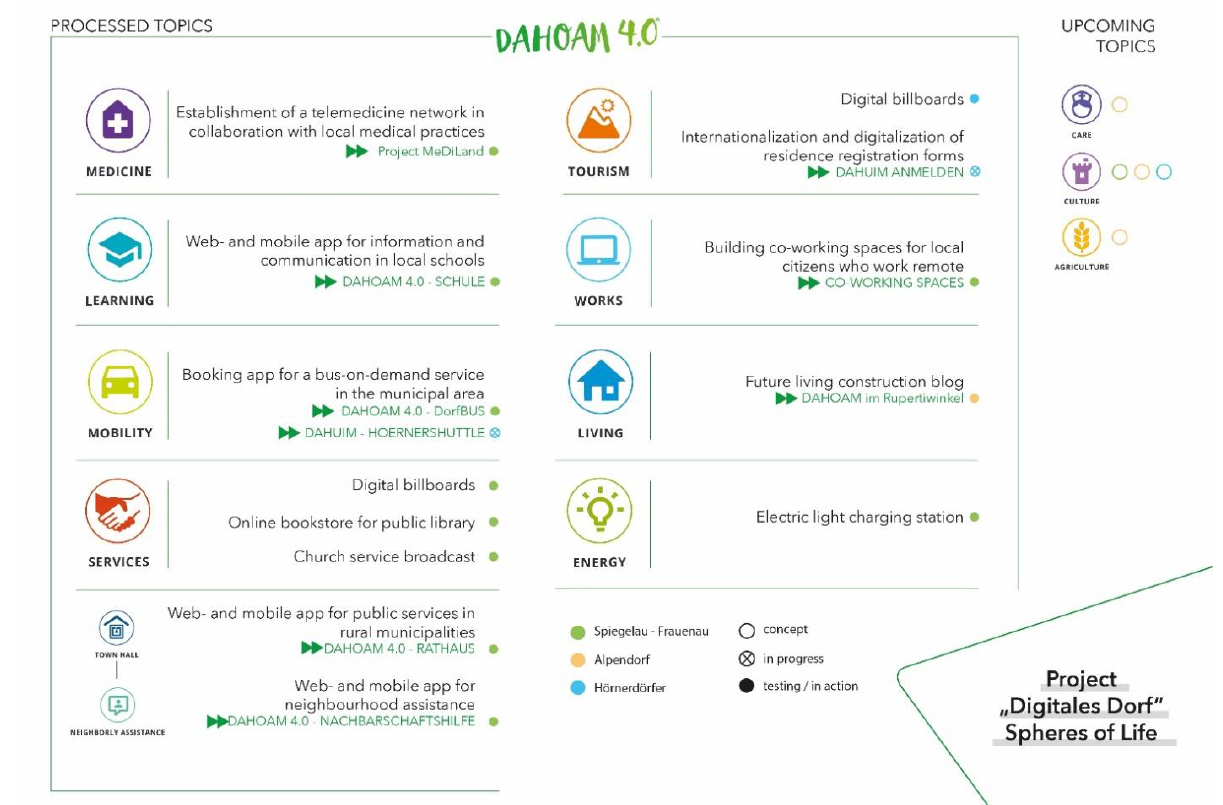
Figure 3: Defined topics aka spheres of life in the living labs, source: own